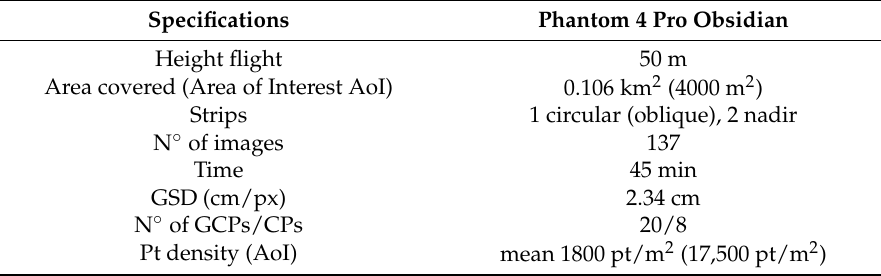
Table 2. UAV acquisition